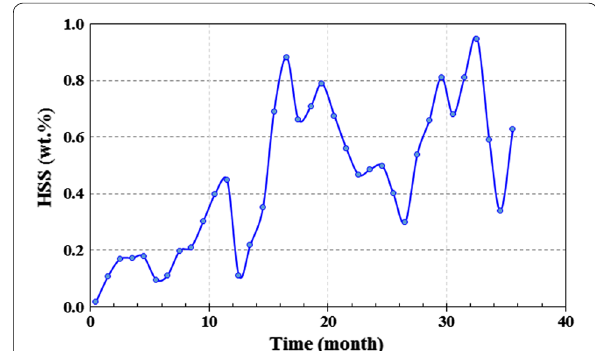
Fig. 8 Heat stable salts (HSS) value throughout the 36 months in amine gas sweetening loop